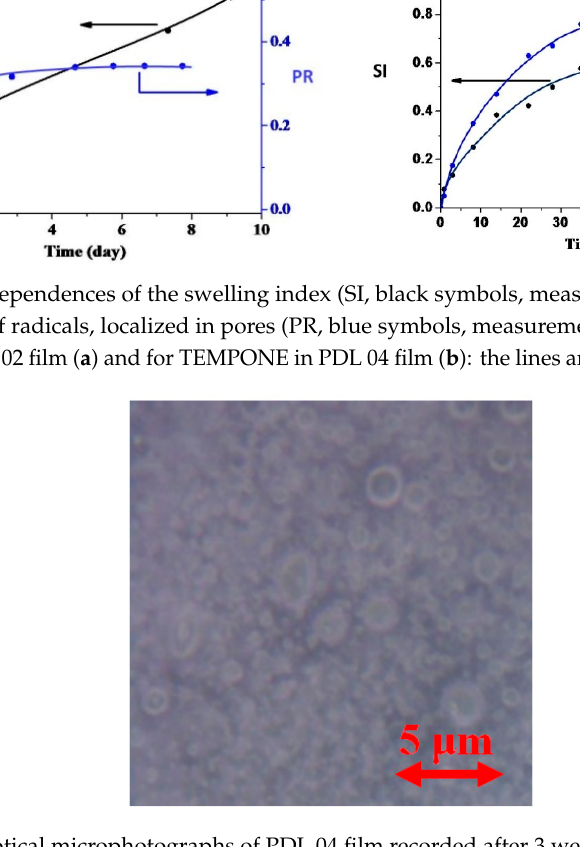
Figure 10. Optical microphotographs of PDL 04 film recorded after 3 weeks of keeping in PBS.